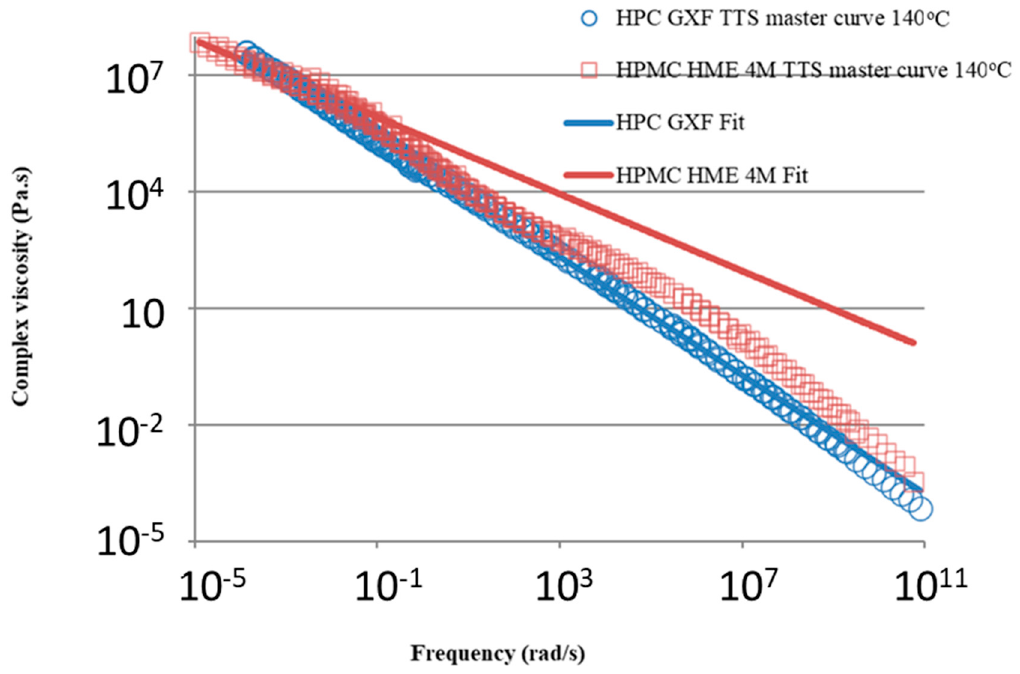
Figure 6. Complex viscosity vs. frequency data of HPMC HME 4M and HPC GXF in one master curve at the reference temperature of 140 ◦ C. The modified Carreau-Yasuda model was used to fit the experimental data.